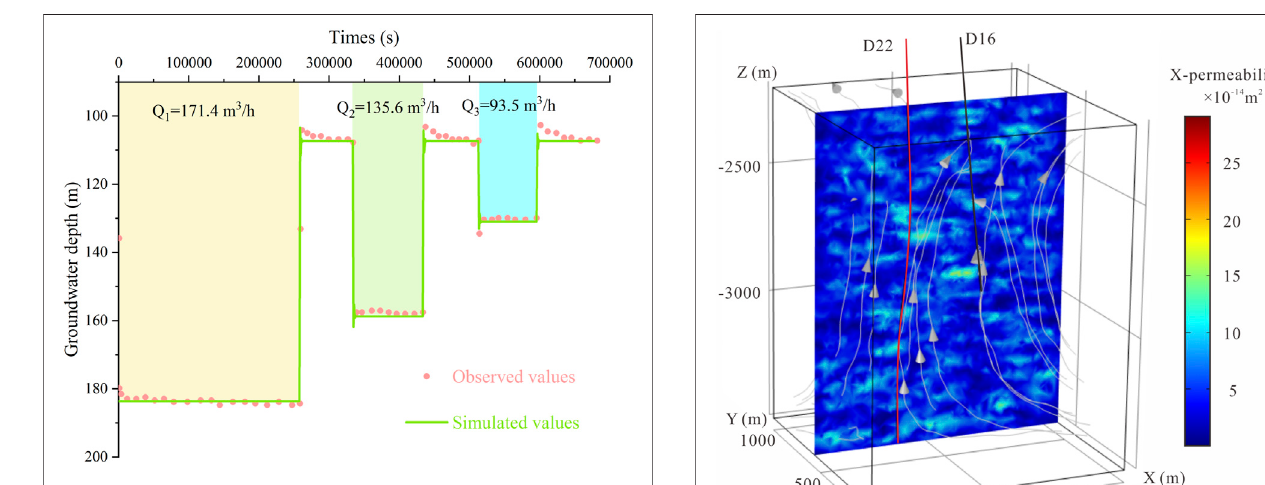
FIGURE 9 | Fitting of simulated and pumping test water levels in well D16.